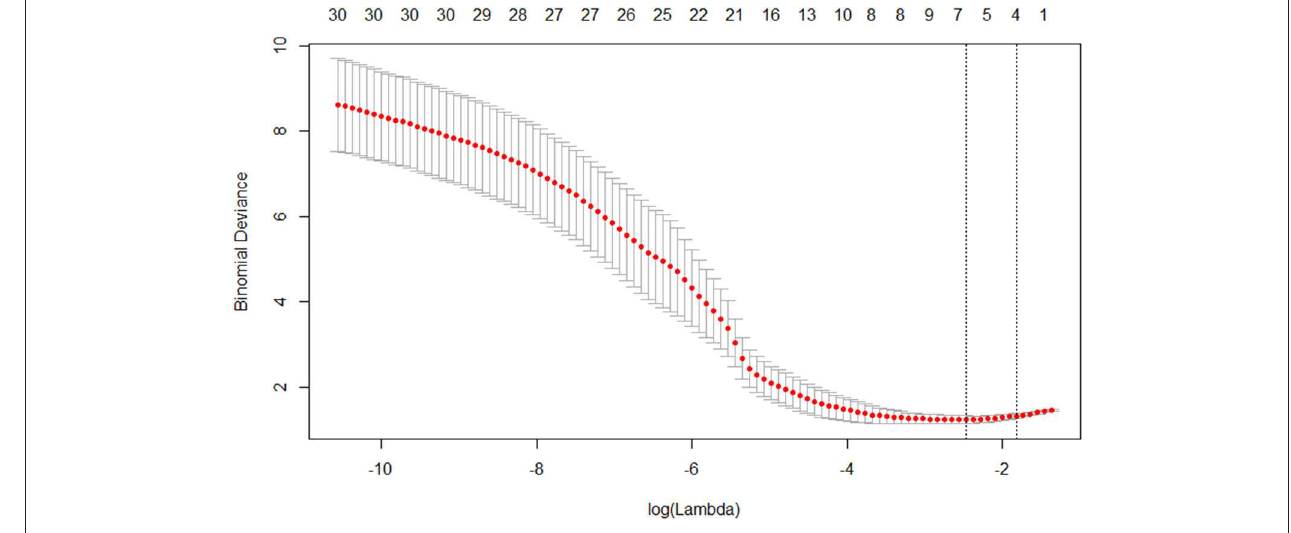
FIGURE 3 | Plot of coefficients-lambda obtained by LASSO.